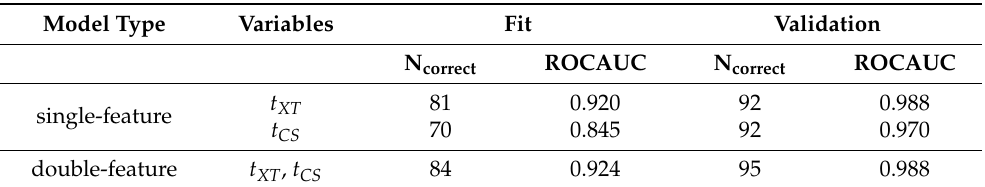
Table 1. Models built on the training set collected here and validated on the Franco data set using single-feature (Equation (2)) and double-feature (Equation (4)) logistic regression (LogReg) models. The sizes of the collected and Franco sets are equal to 100 molecular